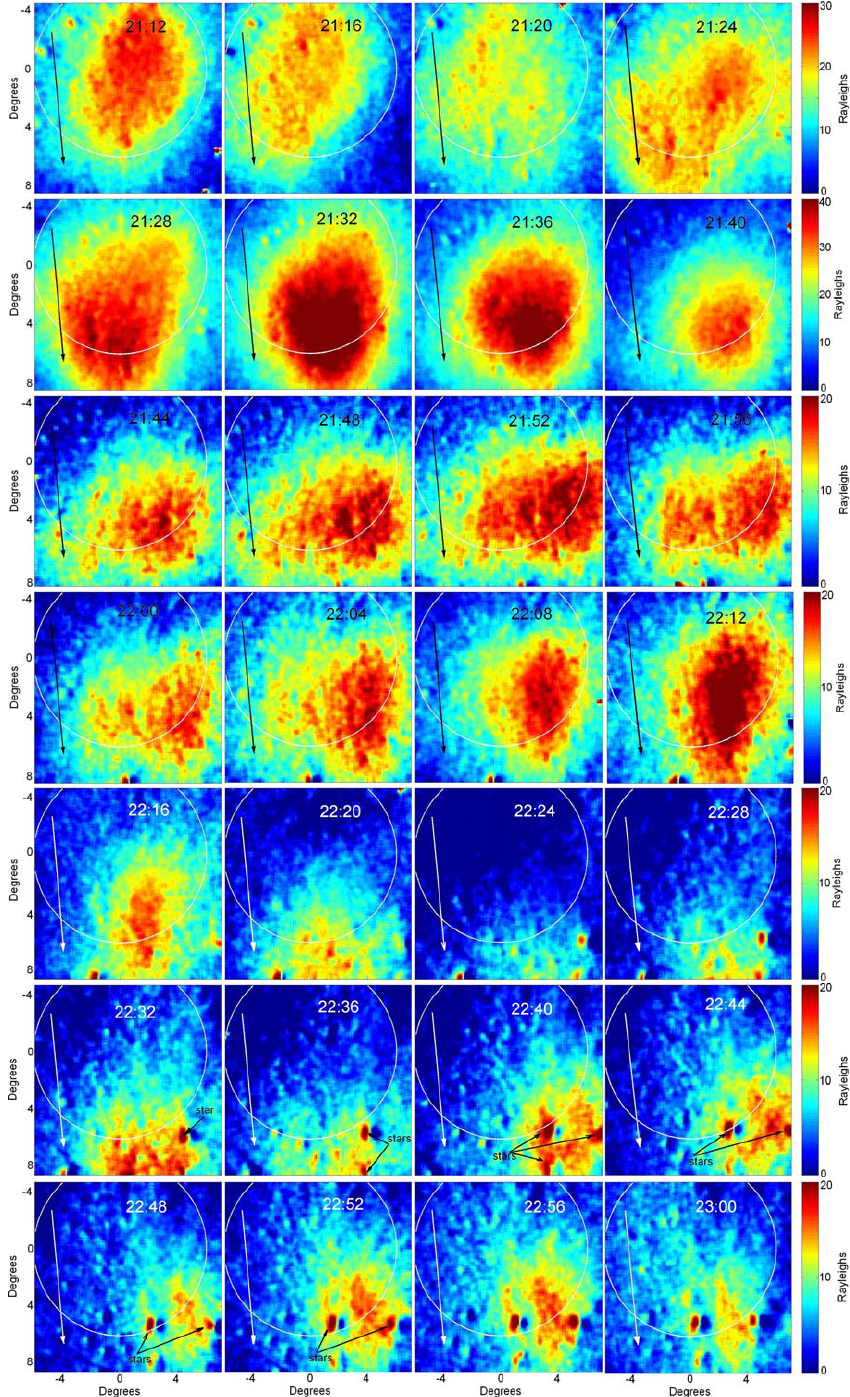
Fig. 3. A collection of images of artificial airglow patches obtained on 15 September 2005. Each panel corresponds to the integration over the last 27s of a 2-min “pump-on” cycle. The end times of each integration ( + 5s) are shown in the panels. The calibration, white circles and arrows are the same as in Fig. 2. North and east are at the bottom and right of each image.